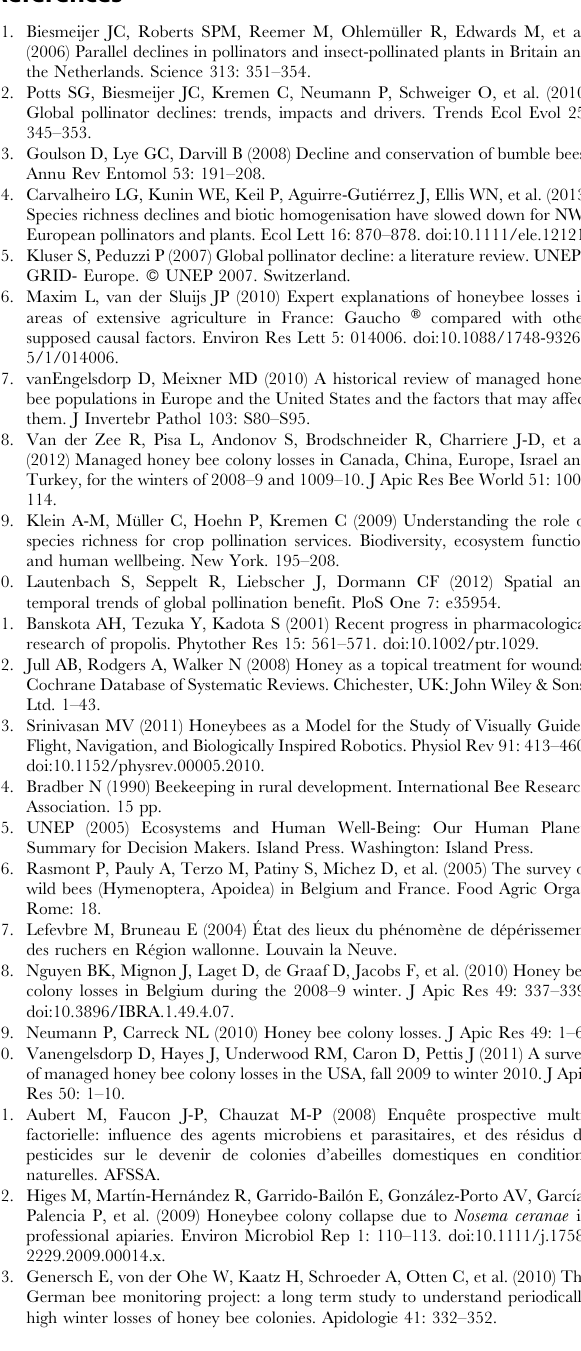
Table S1 Diversity of pollens collected in the apiaries before the